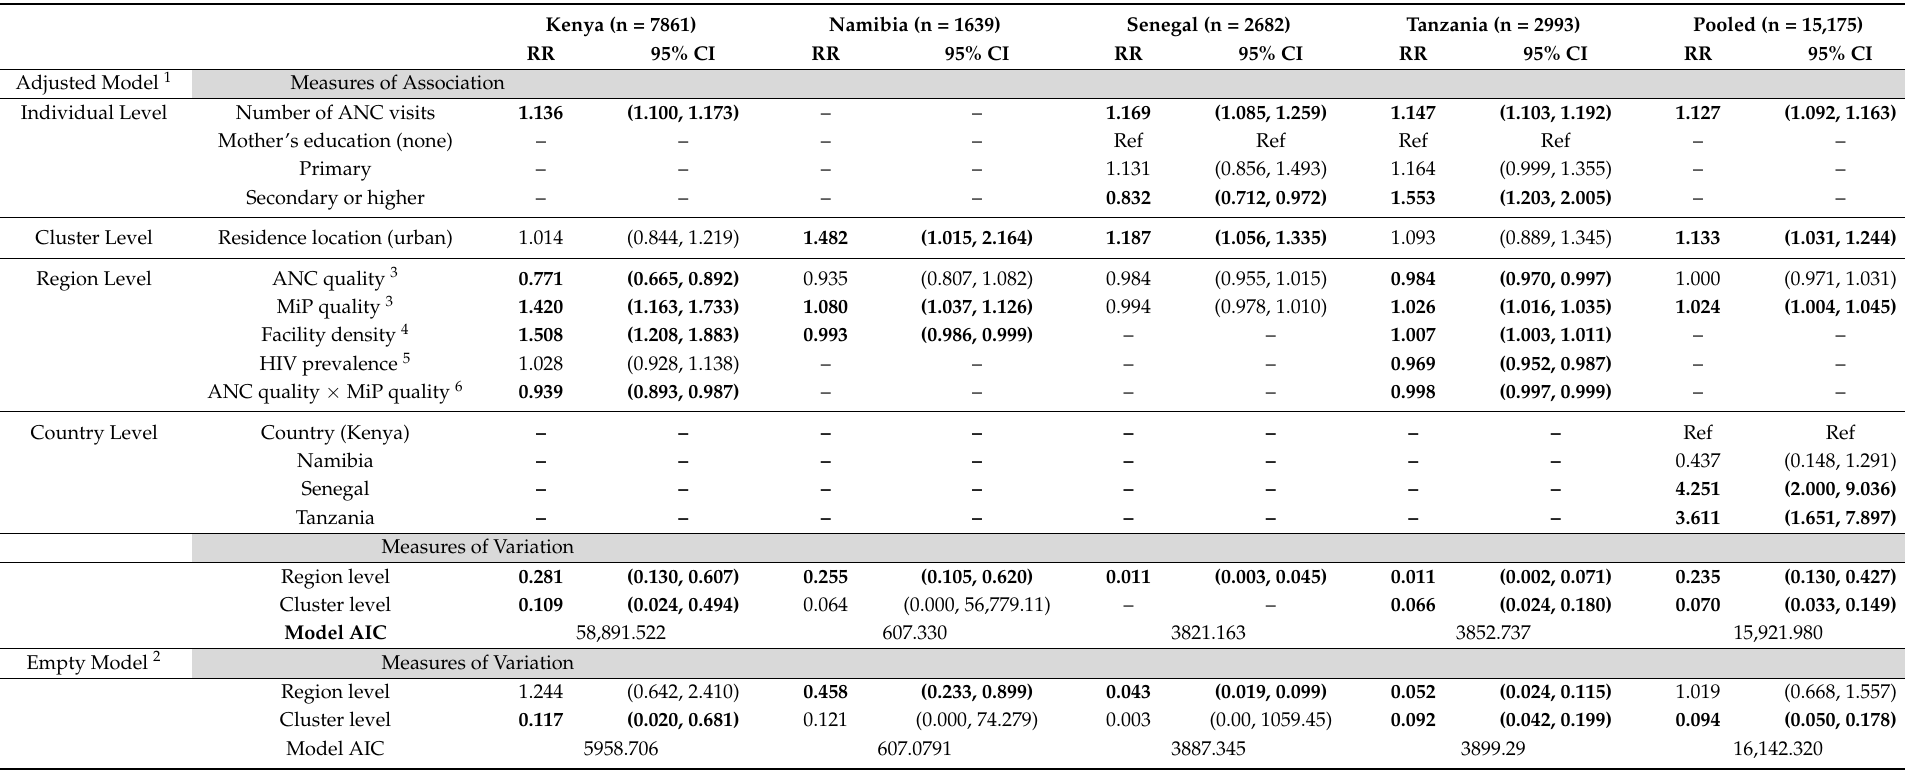
Table 3. Adjusted multilevel mixed effects modified Poisson results for intermittent preventive treatment in pregnancy